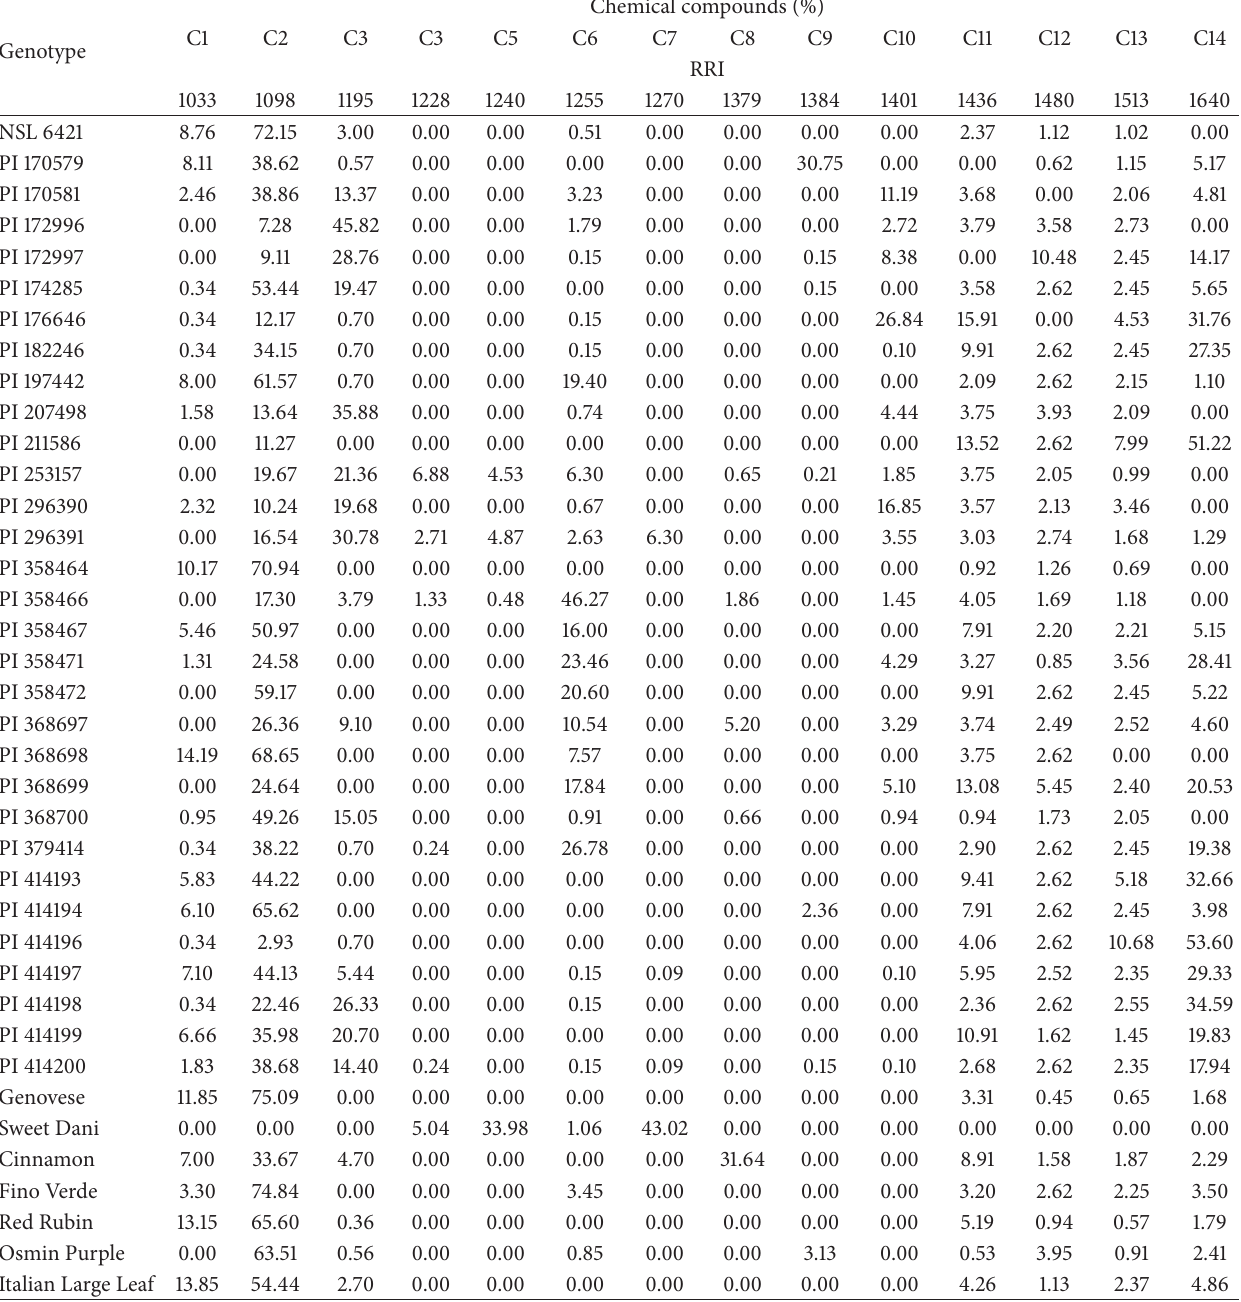
RRI: Relative Retention Index. Identification of the chemical constituents: C1 = 1,8-cineole, C2 = linalool, C3 = methyl chavicol, C4 = nerol, C5 = neral, C6 = geraniol, C7 = geranial, C8 = methyl cinnamate, C9 = 𝛽 -bourbonene, C10 = methyl eugenol, C11 = 𝛼 - trans -bergamotene, C12 = germacrene-D, C13 = 𝛿 - cadinene, and C14 = epi - 𝛼